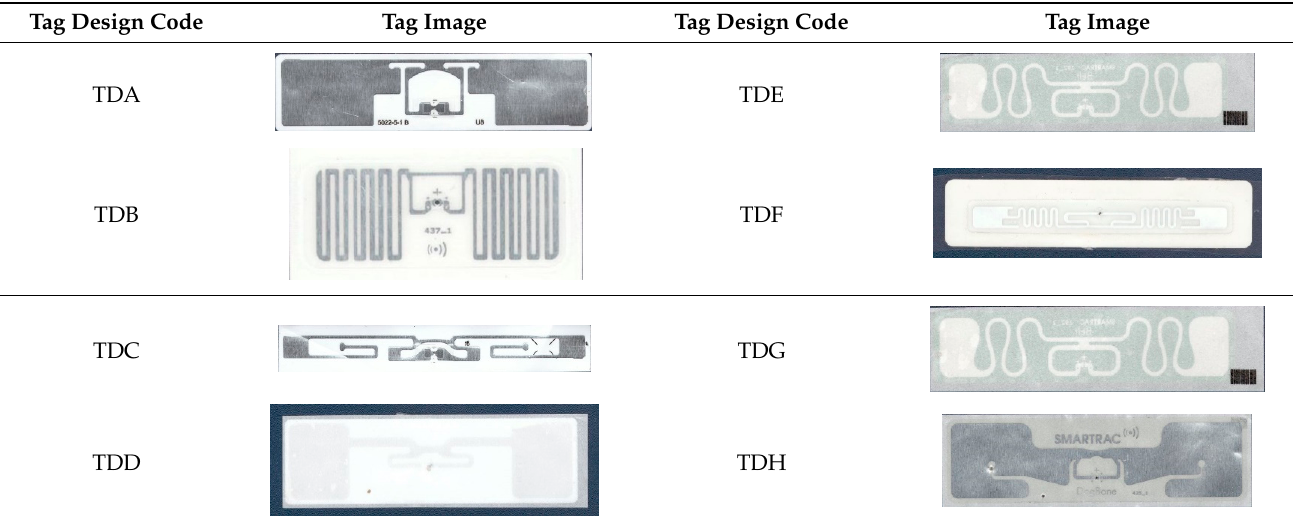
Table 1. RFID passive tag designs representing variation in inlay patterns and sizes.